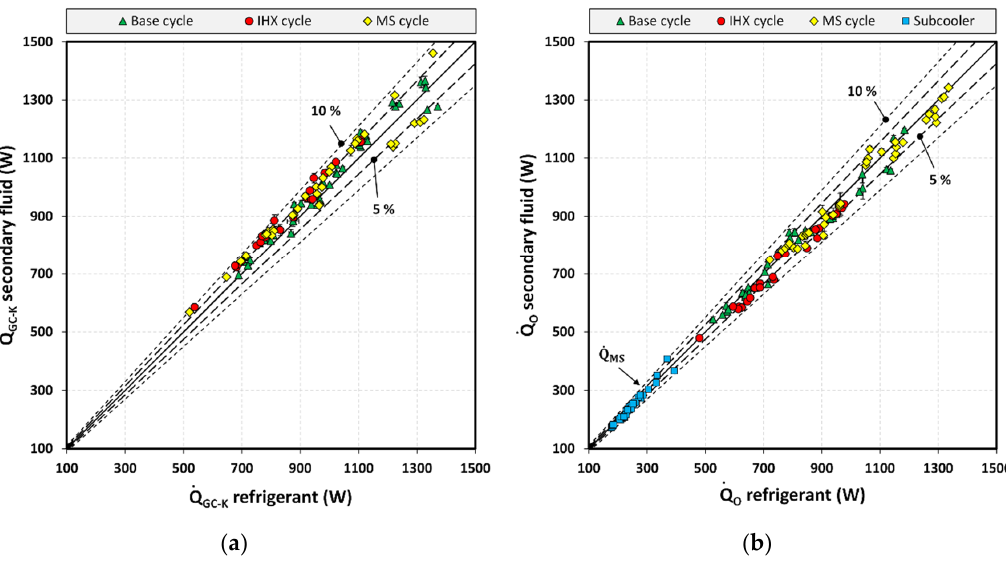
Figure 2. Experimental data validation: ( a ) cooling capacity ( b ) heat rejection power and subcooler capacity.